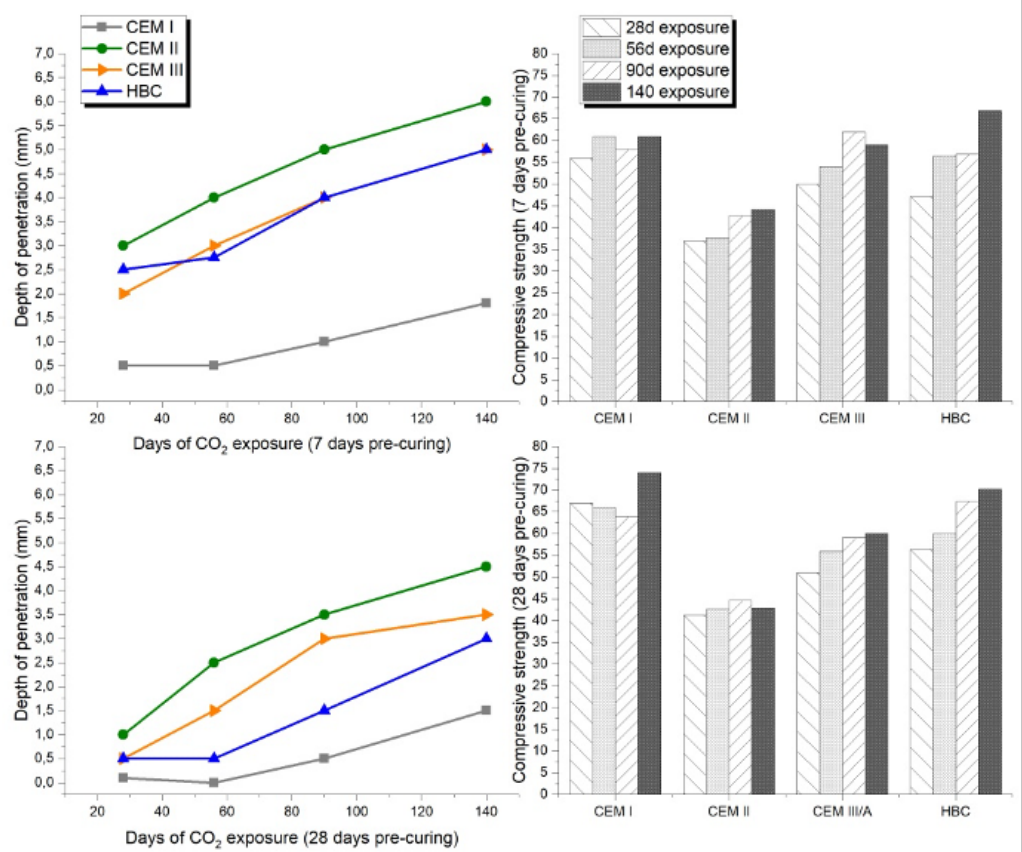
Figure 6. Accelerated carbonation (4% CO 2 at 20 ◦ C, and 70% RH) and influence on the strength